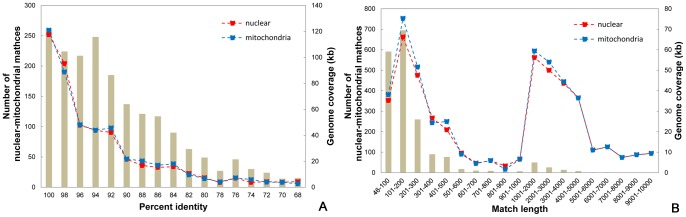
Characteristics of nuclear-mitochondrial sequences in soybean.Results are based on a BLAST e-value cutoff of 1e–12. (A) Distributions of percent identities between shared nuclear-mitochondrial matches. The number of matches is shown by brown boxes and is plotted on the left ordinate. The red and blue square lines show the coverage of matches on nuclear and mitochondrial genomes, respectively, and are plotted on the right ordinate. (B) Distributions of lengths between shared nuclear-mitochondrial matches; the notation method is the same as for (A).